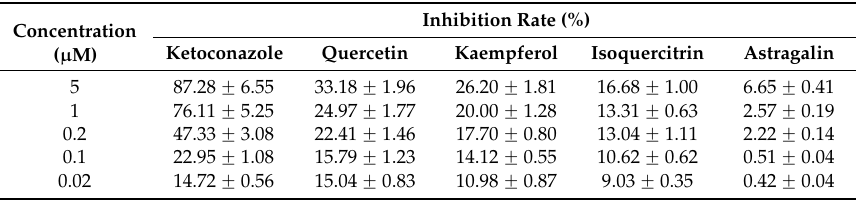
Table 4. Effects of flavonoids on CYP3A4 isozyme activities ( x ˘ s, n =